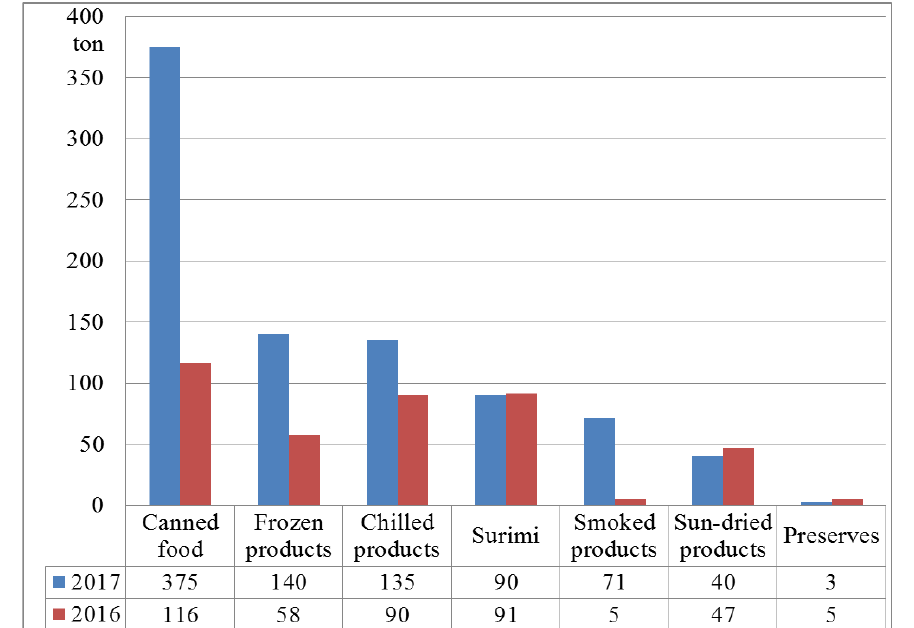
Fig. 2. The export of fish and fish products of Ukraine in 2016–2017 (according to the State Statistics Committee of Ukraine)